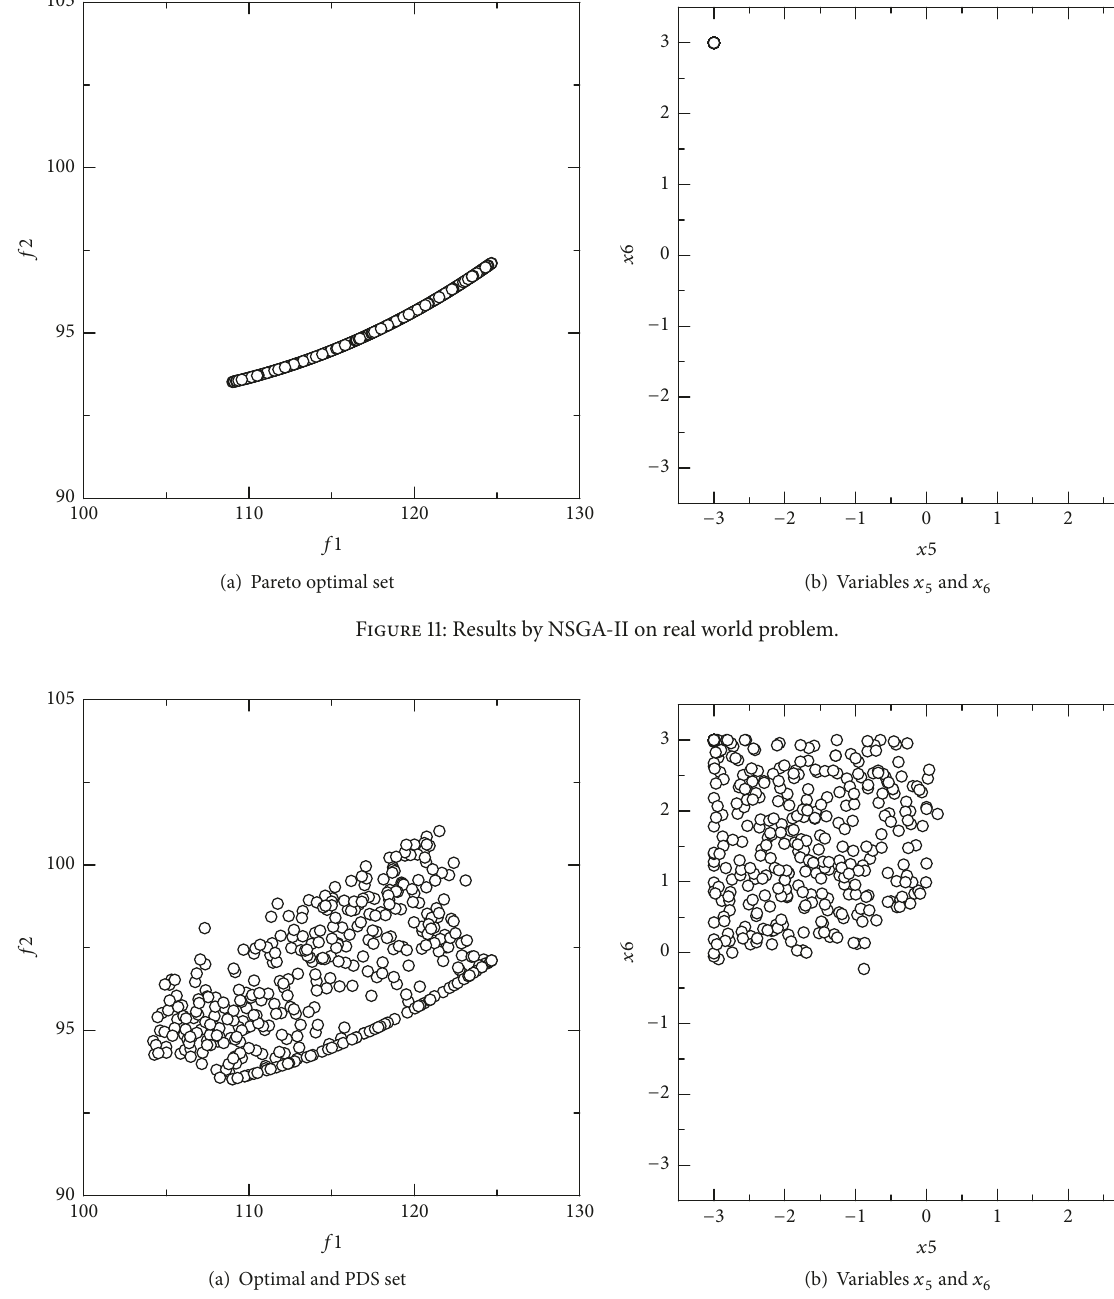
Figure 12: Results by the proposed two-population concurrent evolution method on real world problem, 𝑑 = 5